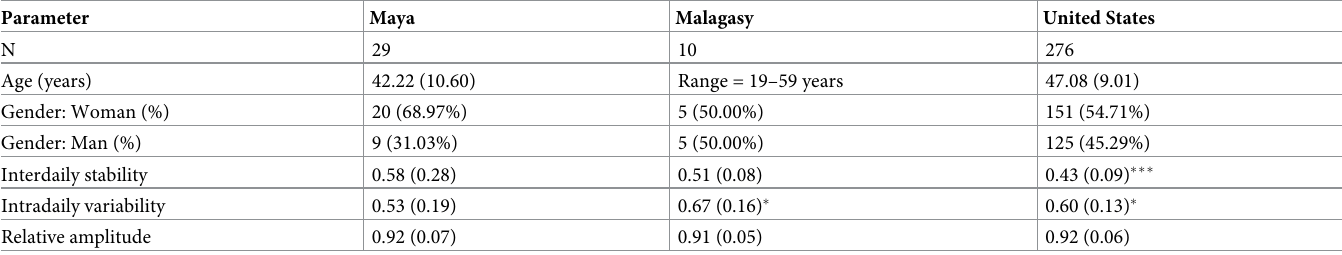
Table 2. NPCRA comparing Maya, Malagasy [16], and industrial United States participants.